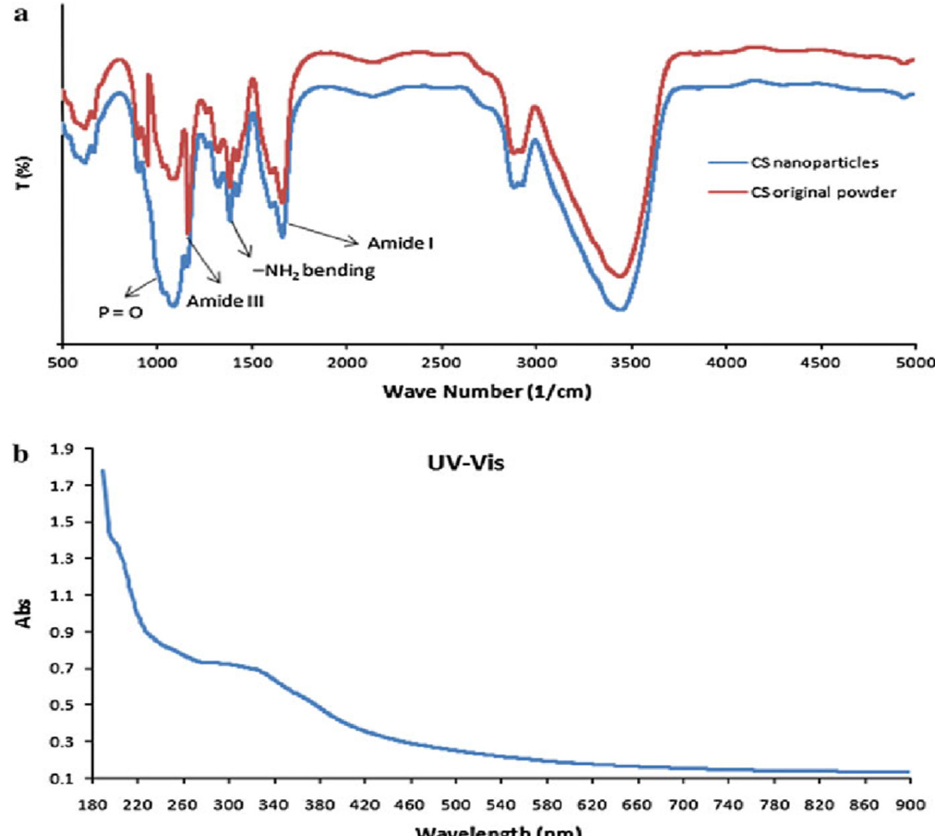
Figure 1. Characterization of chitosan nanoparticles. Note that Figures ( a ) and ( b ) are FTIR and UV-vis, respectively.